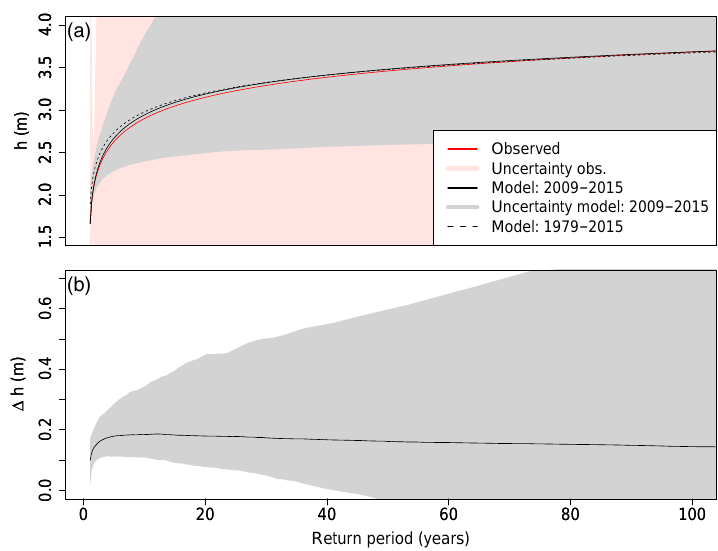
Figure 9. Conditional model. (a) Return levels of the impact h with associated 95% uncertainty intervals. The return level computed on h obs is shown in red (uncertainty shown in light red). The model-based return level computed for the period 2009–2015 (black) is based on h sim values simulated for days where the observed data were available (uncertainty is shown in grey). The model-based return level computed for the period 1979–2015 (black dashed) has an uncertainty of similar amplitude to that of period 2009–2015 (not shown). (b) Difference between the model-based return level obtained when considering the realistic dependence between sea and river levels, and when assuming that they are independent. To make the dependencies between the sea and the river levels independent but keep the dependence between the two rivers, we shuffled the sea level data after each simulation, which guarantees random association between sea data and each of the rivers (e.g. Van den Hurk et al., 2015). The black line represents the median of the bootstrap